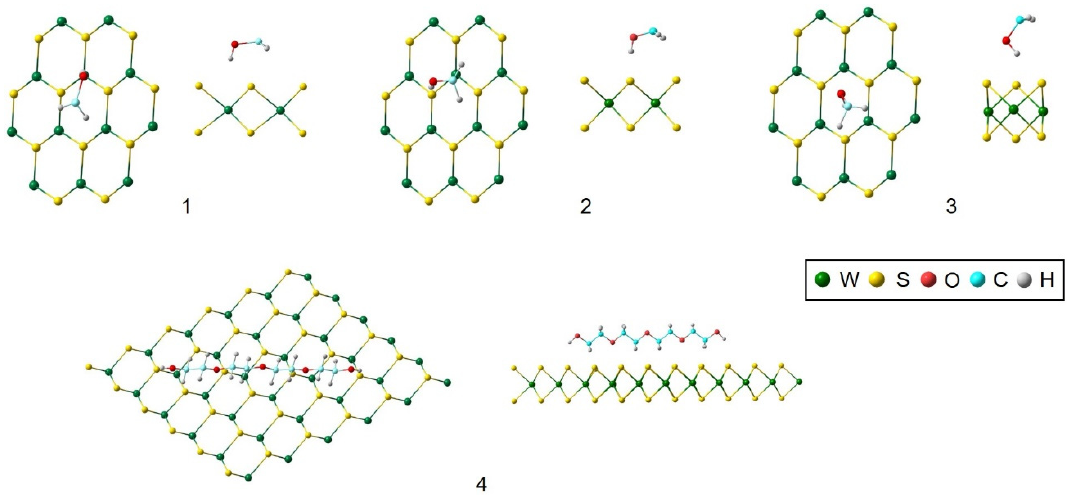
Figure 2. Local geometry for the interaction of polyethylene glycol (PEG) with the WS 2 surface.